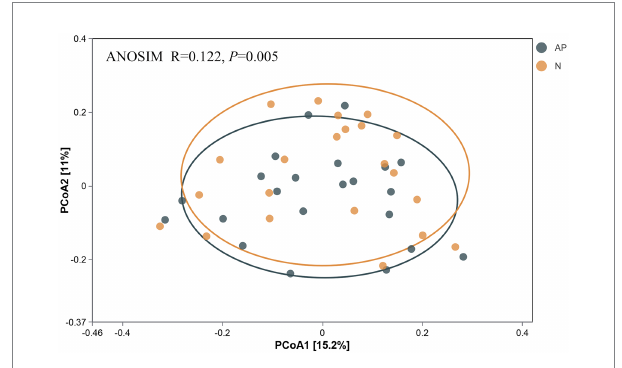
FIGURE 1 Bacterial community beta diversity. PCoA analysis of bacterial community in A . palmeri (AP) and native(N) rhizosphere soils, respectively; R and p values were calculated via ANOSIM